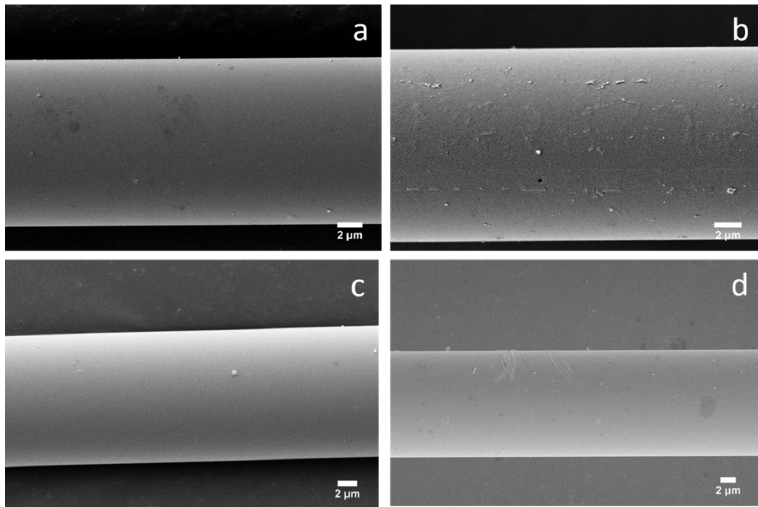
Figure 6. SEM micrographs of ( a ) as-received basalt fibres, ( b ) heat-treated at 600 °C, ( c ) heat treated